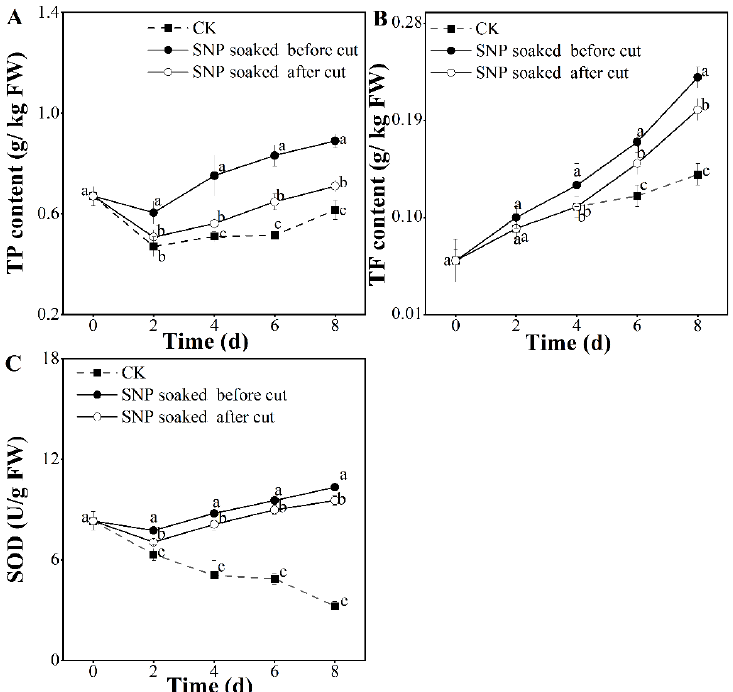
Figure 5. Effect of SNP treatment on antioxidant properties of fresh-cut potatoes. TP ( A ) and TF content ( B ) and SOD activity ( C ). Different letters indicate significant differences among treatments at same storage time ( p <